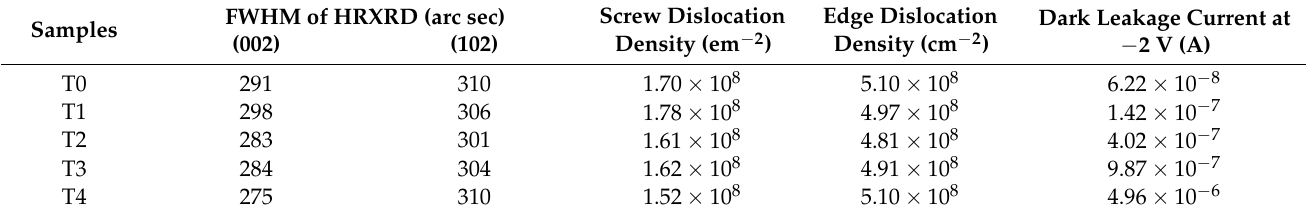
Table 1. The characterization parameters of the T0–T4